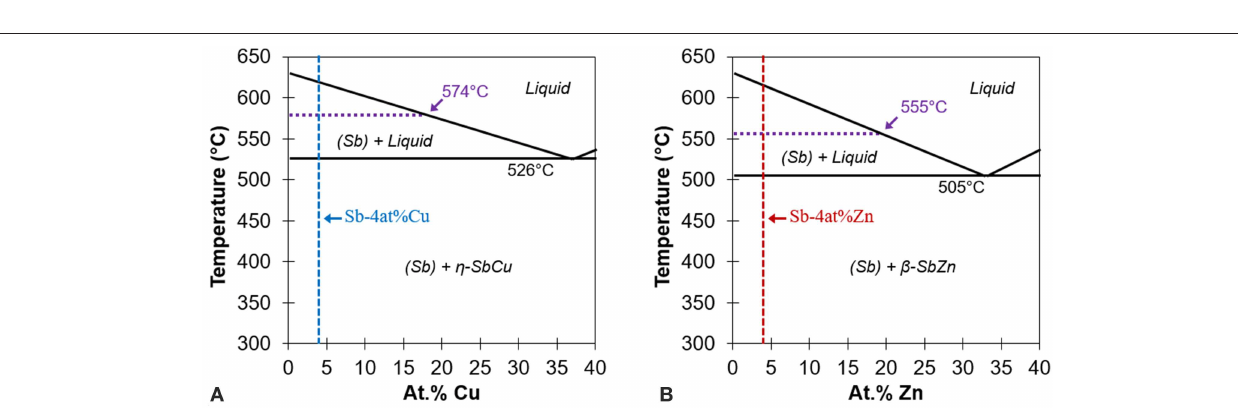
Alfa Aesar) or zinc (99.99% shot, Alfa Aesar,) in boron nitride- coated graphite crucibles at 750 ◦ C until a liquid solution